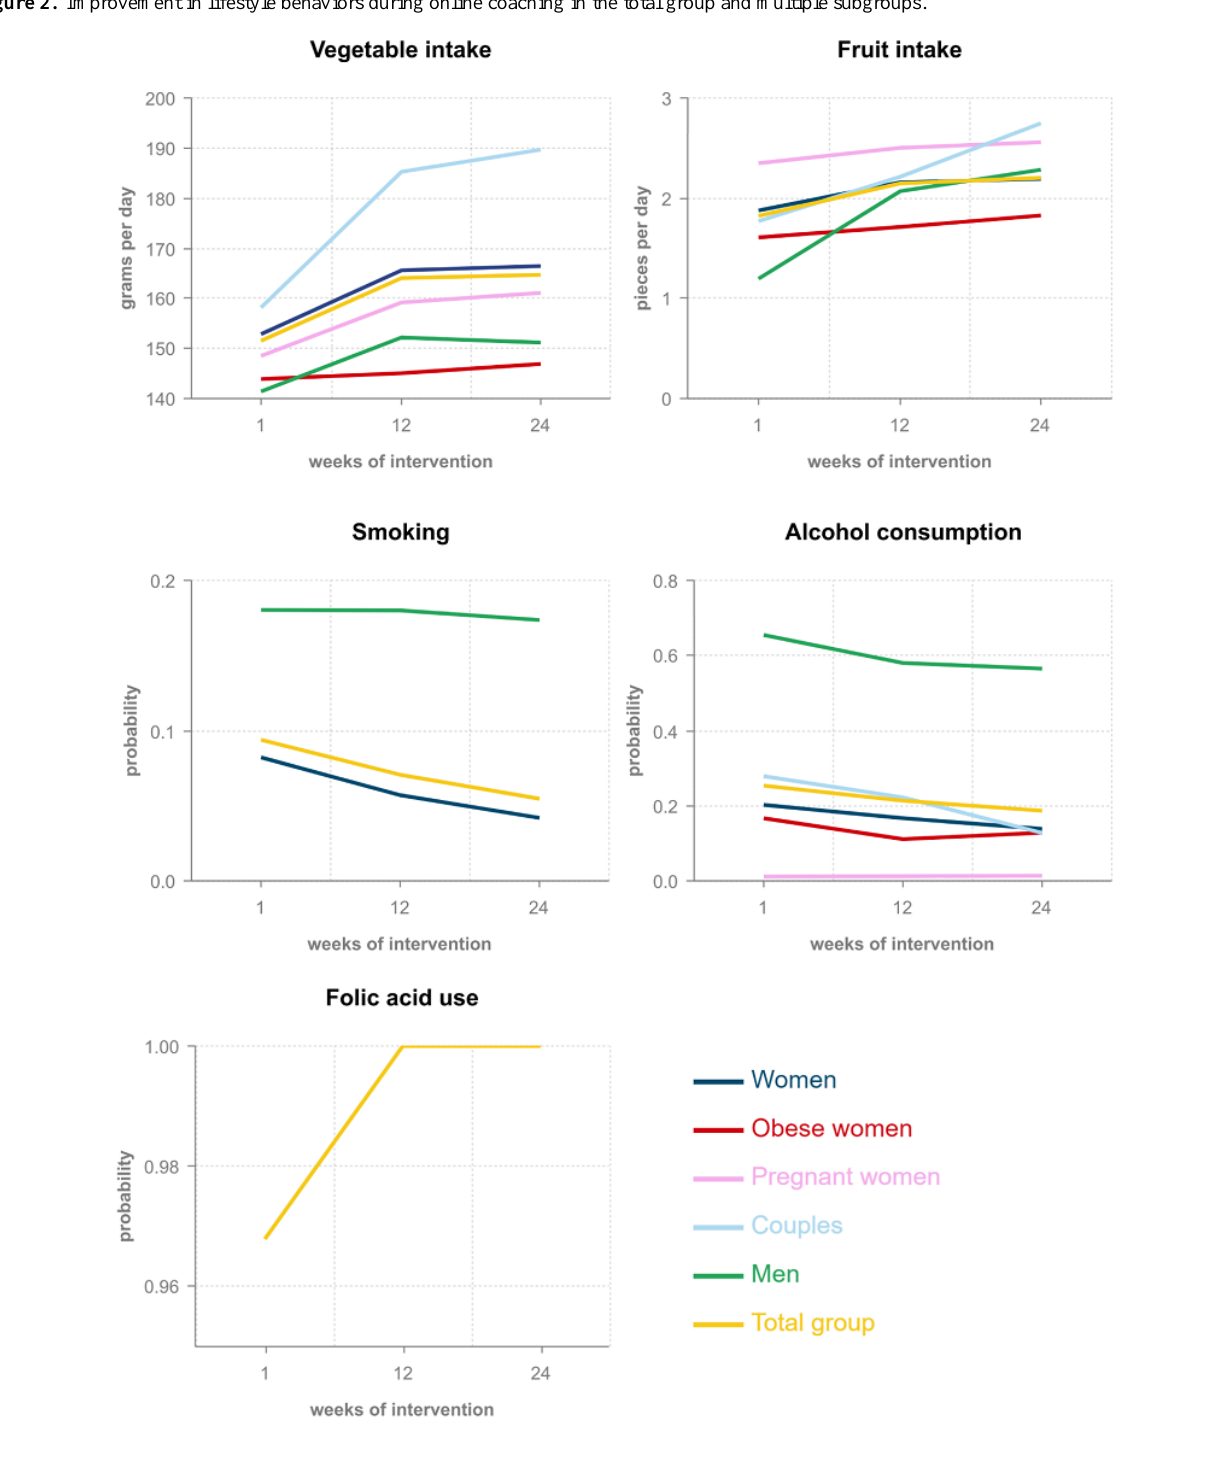
Figure 2. Improvement in lifestyle behaviors during online coaching in the total group and multiple